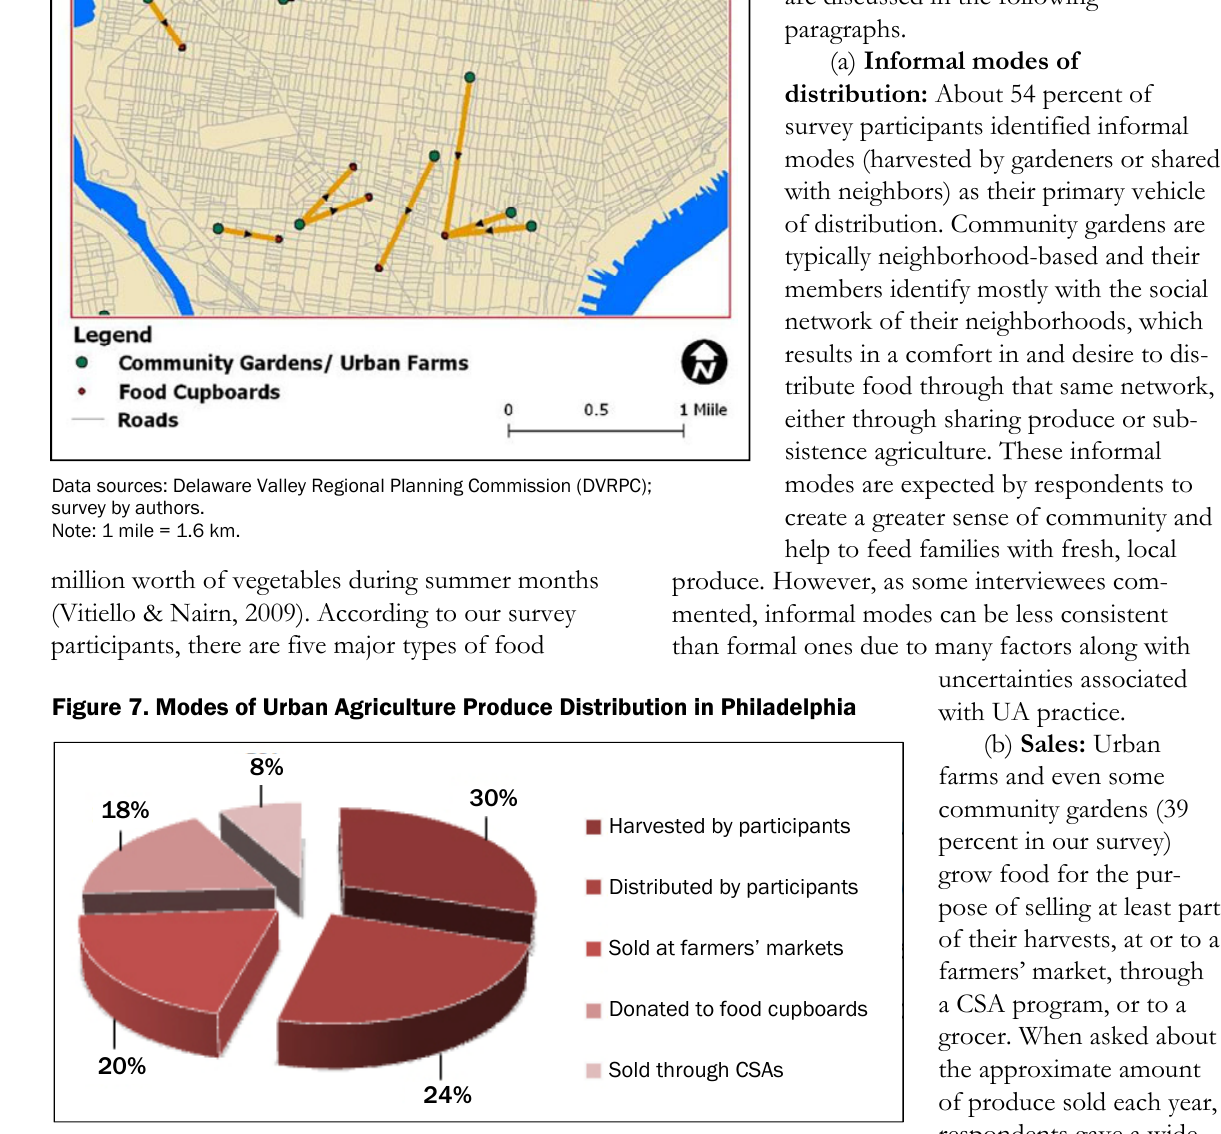
Data source: Survey by authors.